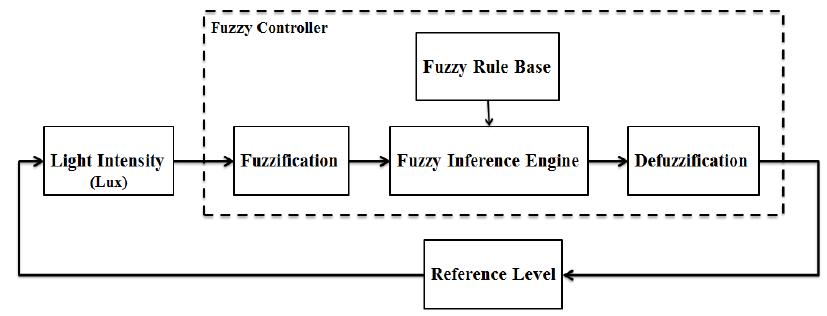
Figure 2. System Architecture diagram of the fuzzy controller.